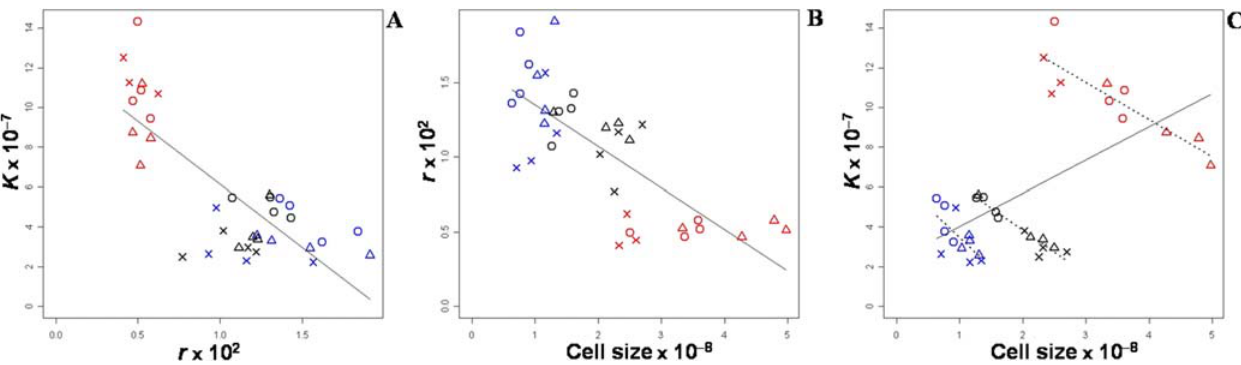
Figure 2. Trade-offs between carrying capacity K (A), growth rate r (B), cell size (C) across culture media. Each point corresponds to the mean value of a strain in a culture condition. Blue, black and red colors correspond respectively to 0.25%, 1% and 15% glucose. Vinery strains are represented by circles, brewery ones by crosses and bakery ones by triangles.